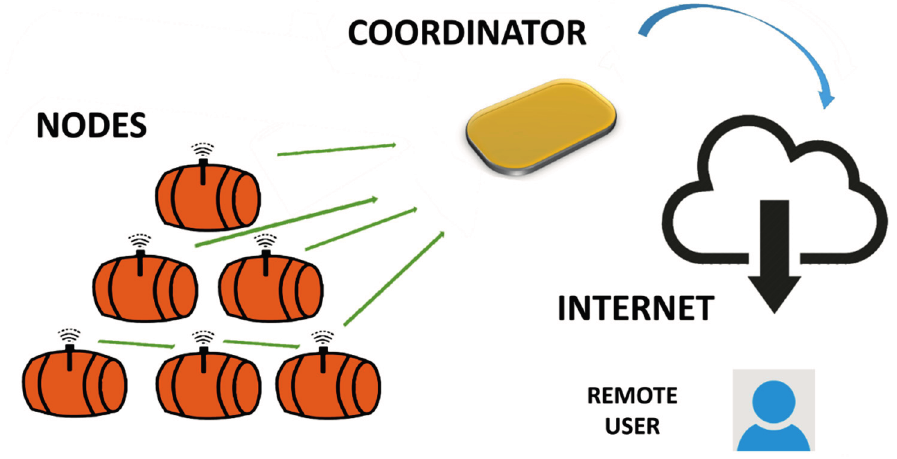
Figure 1. WineDuino system data